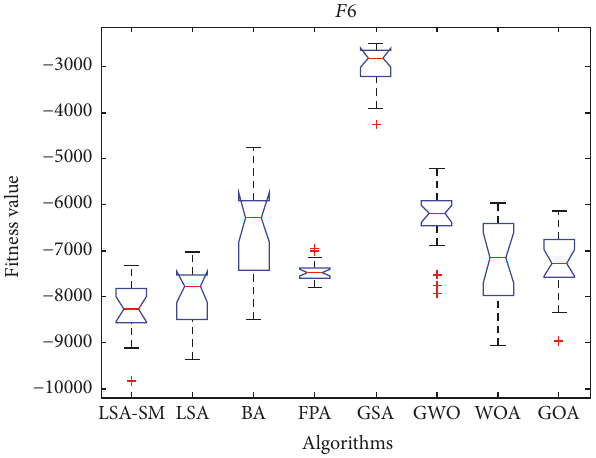
Figure 28: 𝐷 = 30 , ANOVA test of global minimum for 𝑓 06